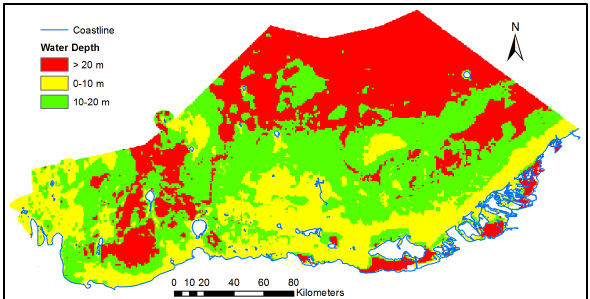
Figure 8: Reclassified water depth